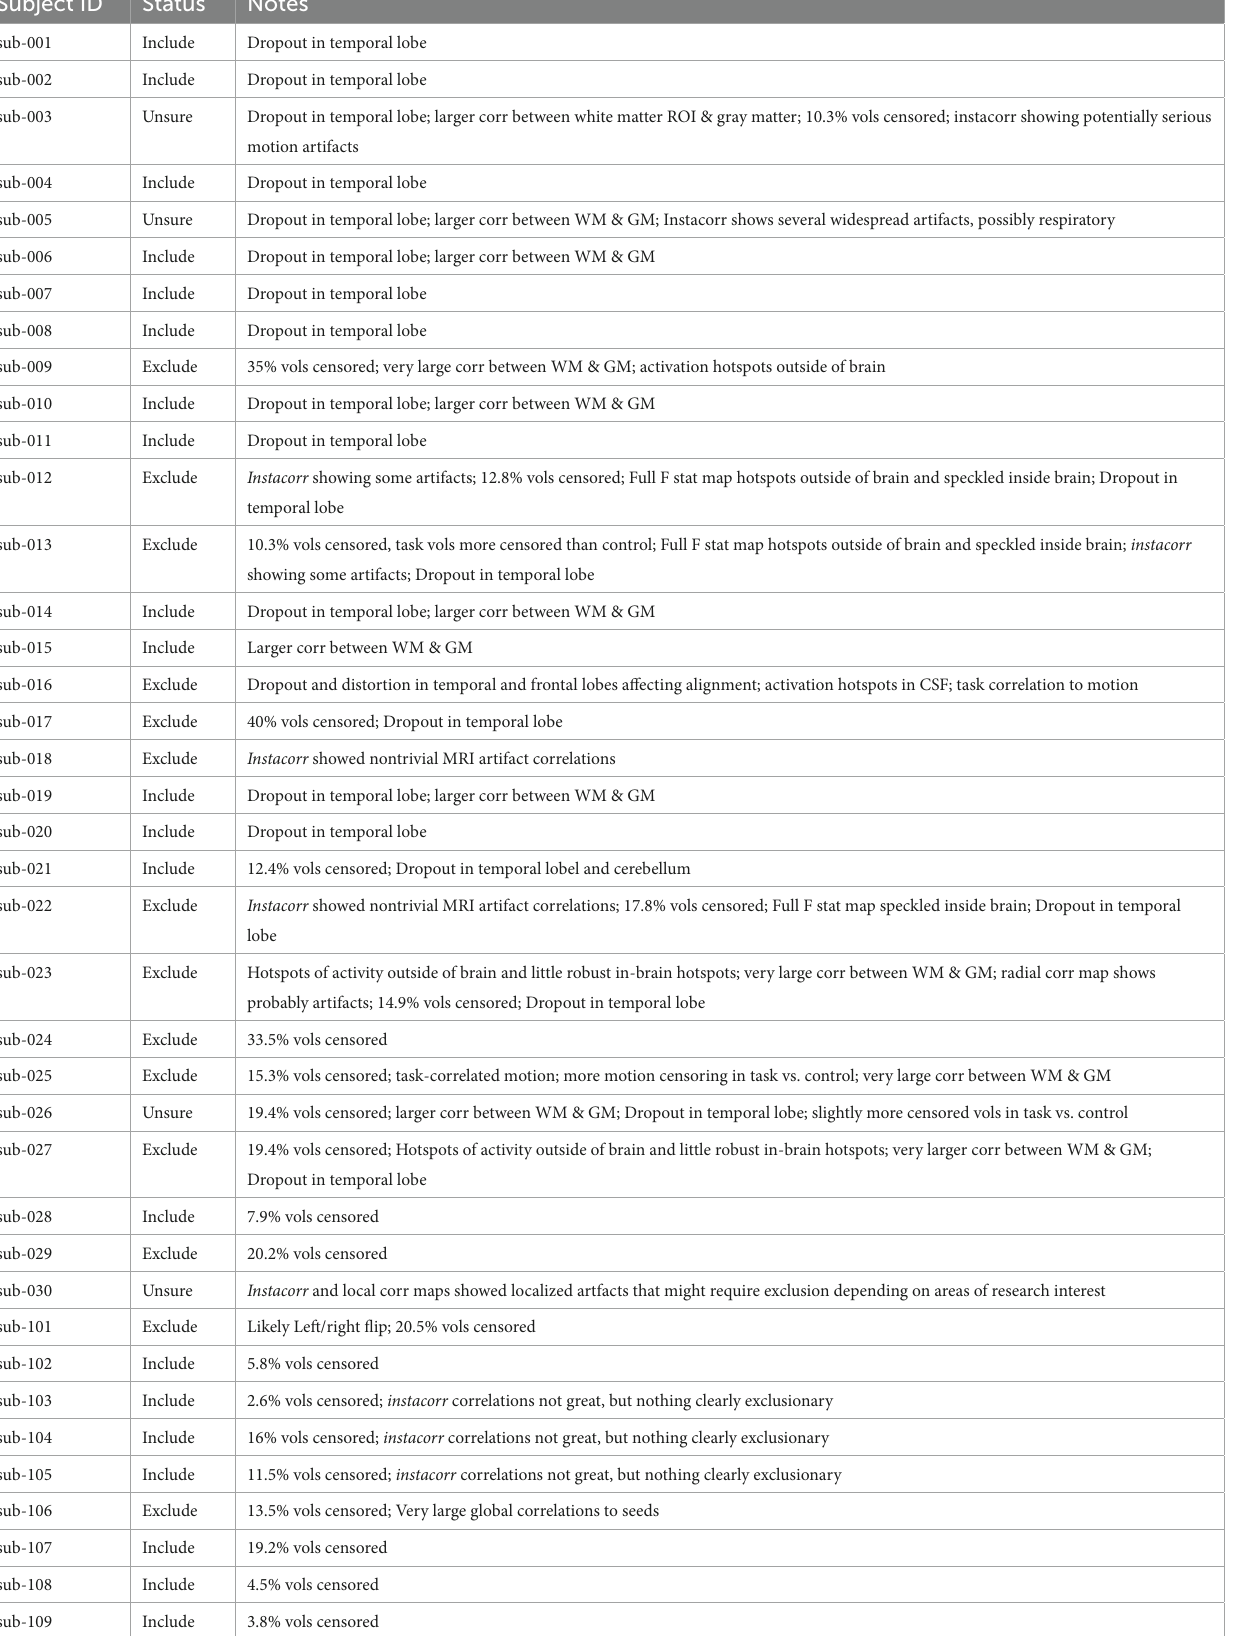
TABLE 1 QC Classifications for all